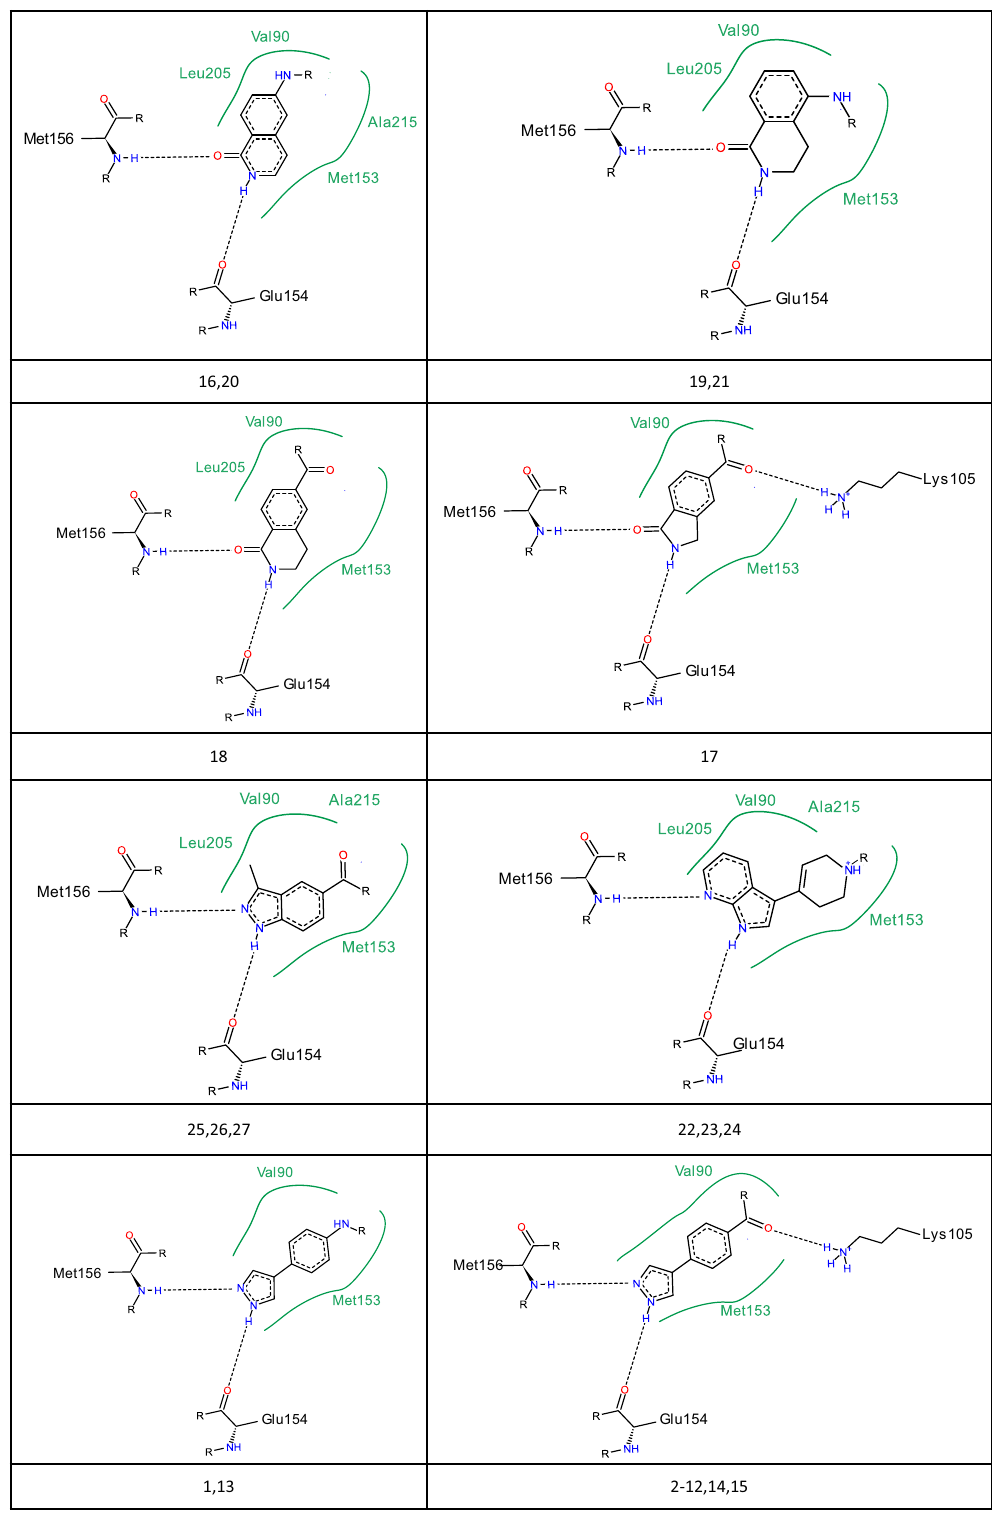
Fig. 2 | Initial fragment hits. Two-dimensional depictions of the initial frag- ment hits that led to one ormore of the fi nal 27 active molecule products.Key protein interactions with the ATP binding site are shown. Below each